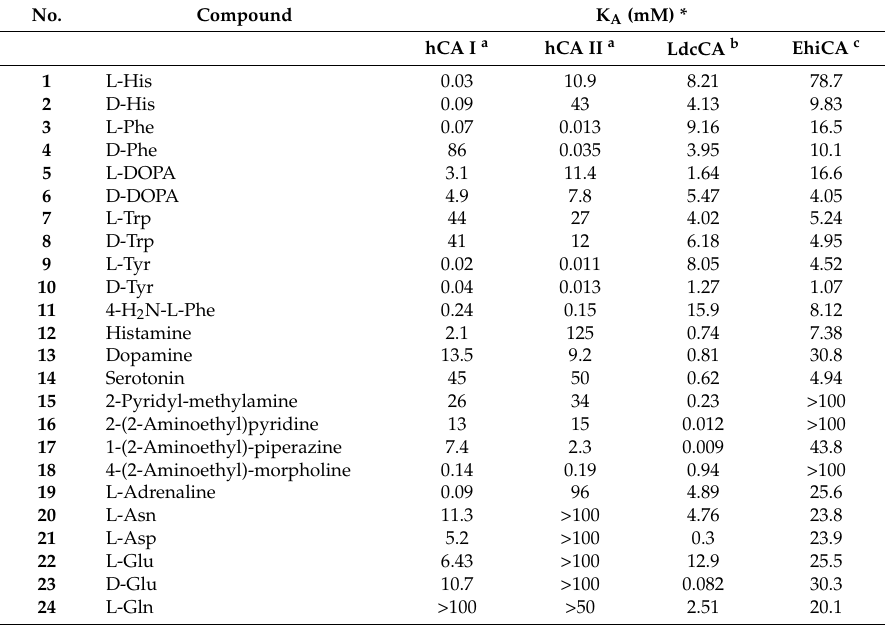
Table 2. Activation constants of hCA I, hCA II and the protozoan enzymes LdcCA ( L. donovani chagasi ) and EhiCA ( E. histolytica ) with amino acids and amines 1 – 24 . Data for hCA I and II are from [32] and for LdcCA from